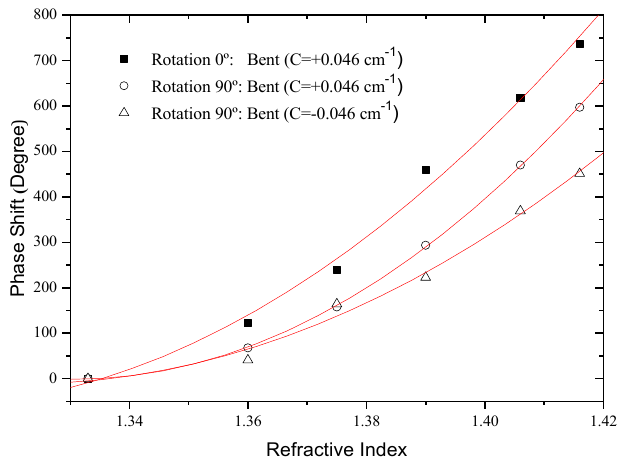
Figure 21. Response of the LPG-based modal interferometer for variation of the external medium refractive index when the fiber is bent in different planes (“Rotation 0°” means curvature in the xy plane).